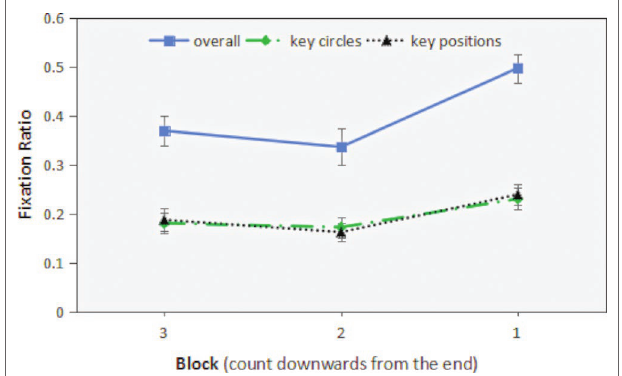
FIGURE 6 | The fixation ration in AOIs in last three blocks. Error bars represent 1